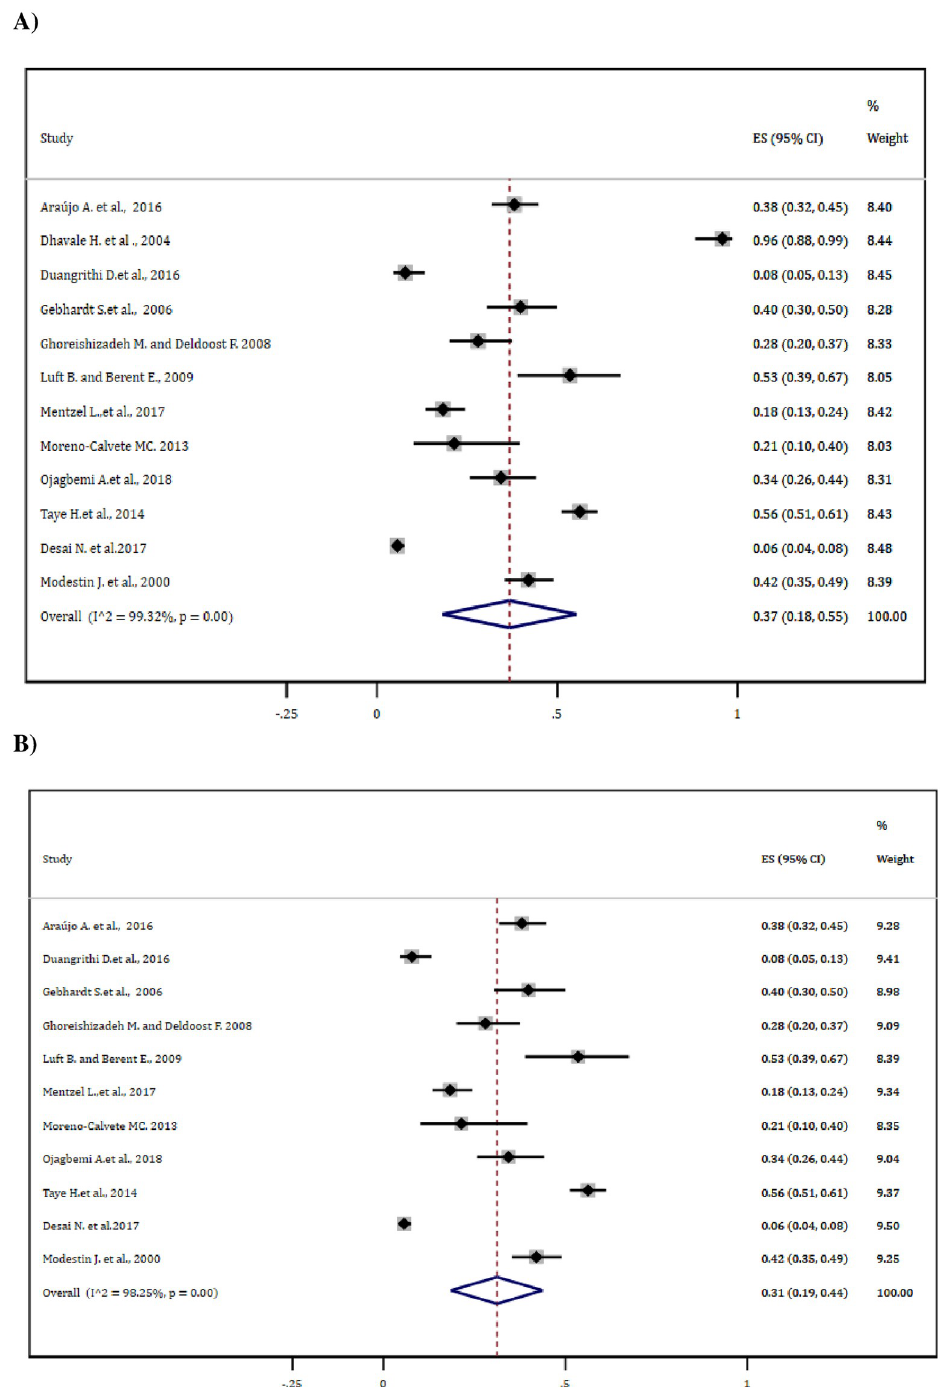
Fig 2. Forest plot depicting the overall antipsychotic-induced EPSE (A) before and (B) after sensitivity analysis. Dopaminergic neurons have four major pathways in the CNS: mesolimbic (from the ventral tegmental area (mid-brain) to limbic system), mesocortical (mid-brain to the prefrontal cortex), nigrostriatal (substantia nigra to striatum), and tuberoinfundibular pathways (hypothalamus to anterior pituitary) [44]. Antipsychotic medication, particularly the conventional antipsychotics